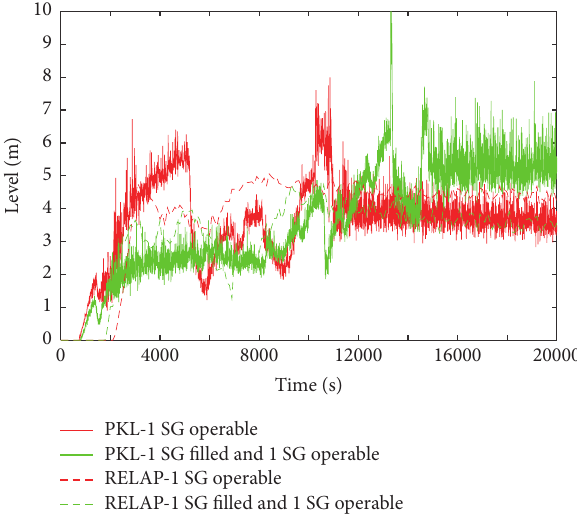
Figure 13: Inlet SG1 level. PKL versus RELAP5. Steam generators influence. Phase I.